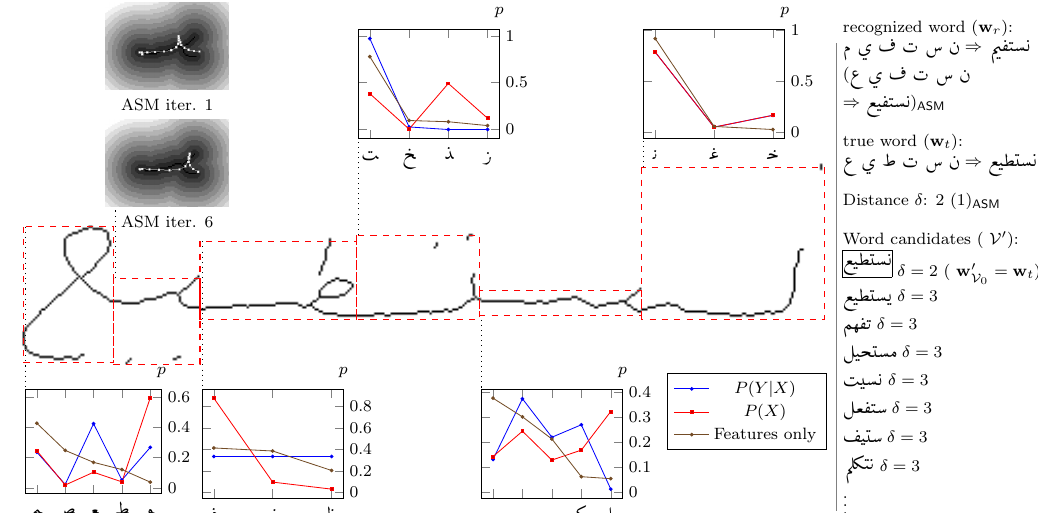
Figure 7. Example output of our word recognition system that uses the proposed segmentation method and SVM/ASM based classification. The diagrams show the SVM based ranking and the a priori knowledge for the single characters. As one can see on the right, the errors of the recognized word w r could be corrected by comparison with the sorted vocabulary V (cid:48)